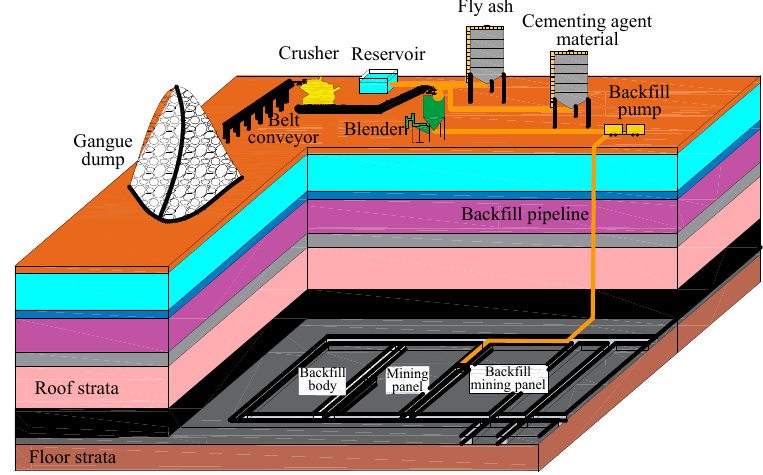
Figure 3. Principle of backfill mining with cemented backfill material.